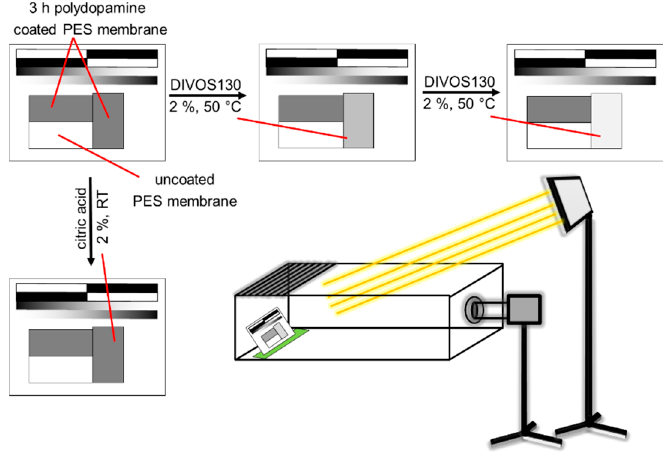
Figure 12. Schematic illustration of the stability test of polydopamine coated membranes against chemical cleaning with DIVOS130 and citric acid. The picture (bottom right) describes the general experimental setup. To keep all distances, angles, light conditions constant the sample was put in a box, open on top with a fixed sample on a sample holder on the left side. Camera settings were fixed in manual mode.